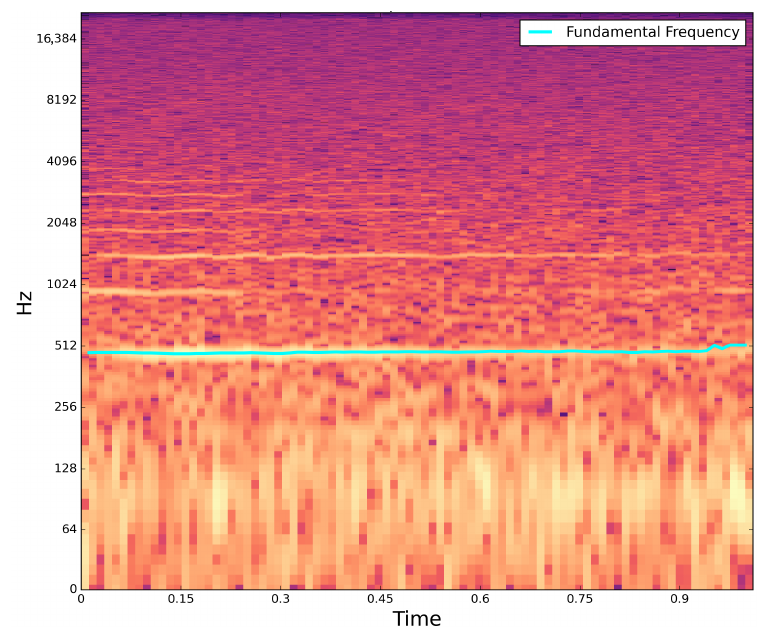
Figure 18. Audio file from an Ae.Aegypti mosquito with a mean frequency of 481 Hz.